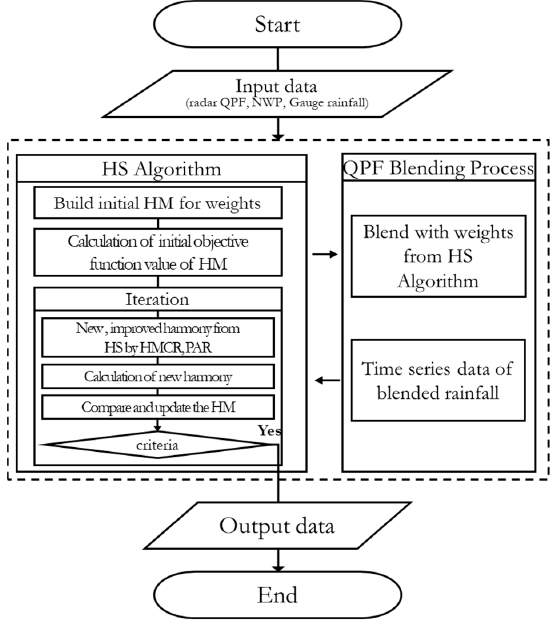
Figure 3. QPF blending process using the harmony search algorithm. HS = harmony search; HM = harmony memory; HMCR = harmony memory considering rate; PAR = pitch adjusting rate.